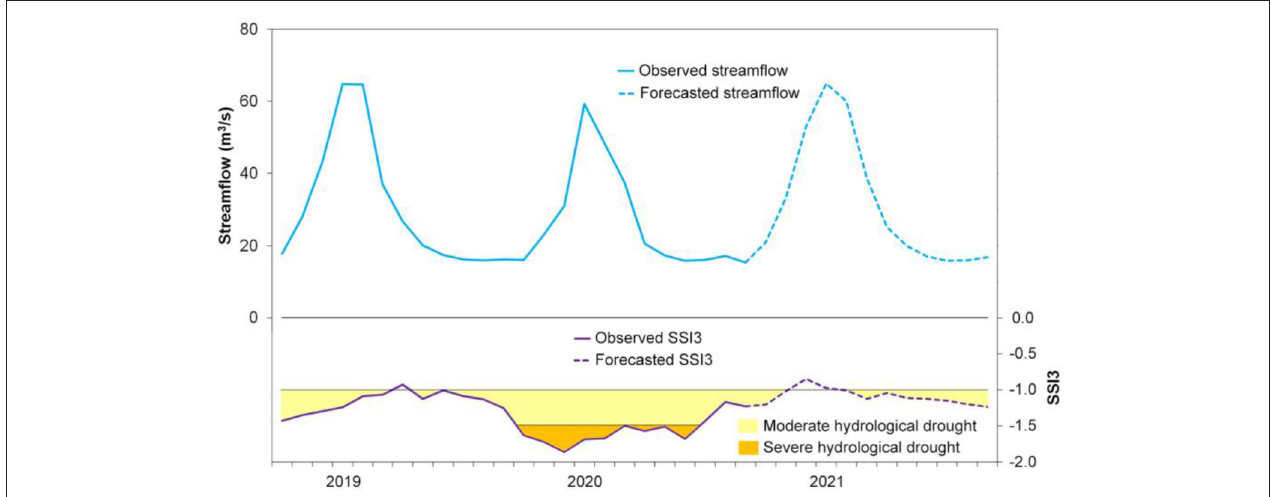
FIGURE 11 | Hydrological drought forecast for the Mendoza River based on the SSI3. The monthly observed streamflow was complemented with the streamflow forecast generated by the DGI from October 2020 to September 2021 to calculate the SSI3 and the corresponding hydrological drought category.